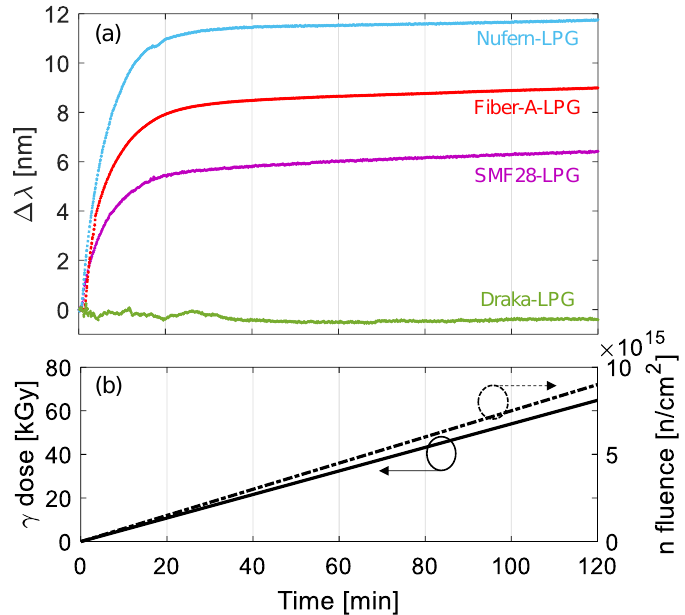
Figure 32. Real-time results of the mixed neutron-gamma irradiation of LPGs arc-induced in different optical fibers: ( a ) resonance wavelength shift; ( b ) irradiation profile (adapted from Ref. [154]).